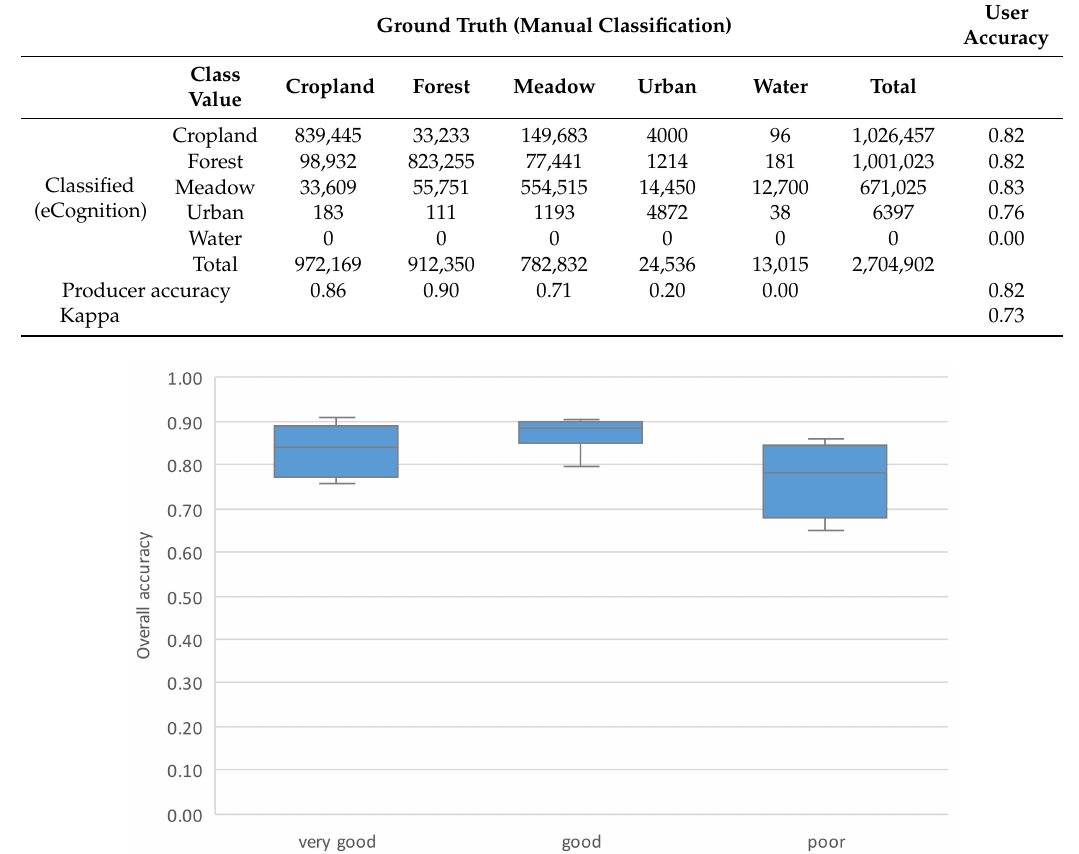
Figure 5. Overall accuracy of the automatic classification compared to the manual reclassification for 17 randomly selected quadrants. Maps were assigned with very good quality, good quality, and poor quality. Detailed results are in Table